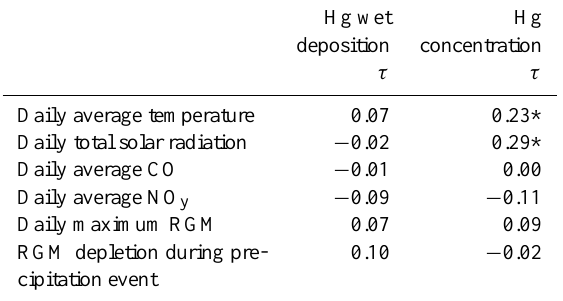
Table 2. Kendall’s τ correlation co-efficients for Hg wet deposition and Hg concentration with meteorological conditions and gas phase measurements at Thompson Farm. Asterisks indicate p < 0 .